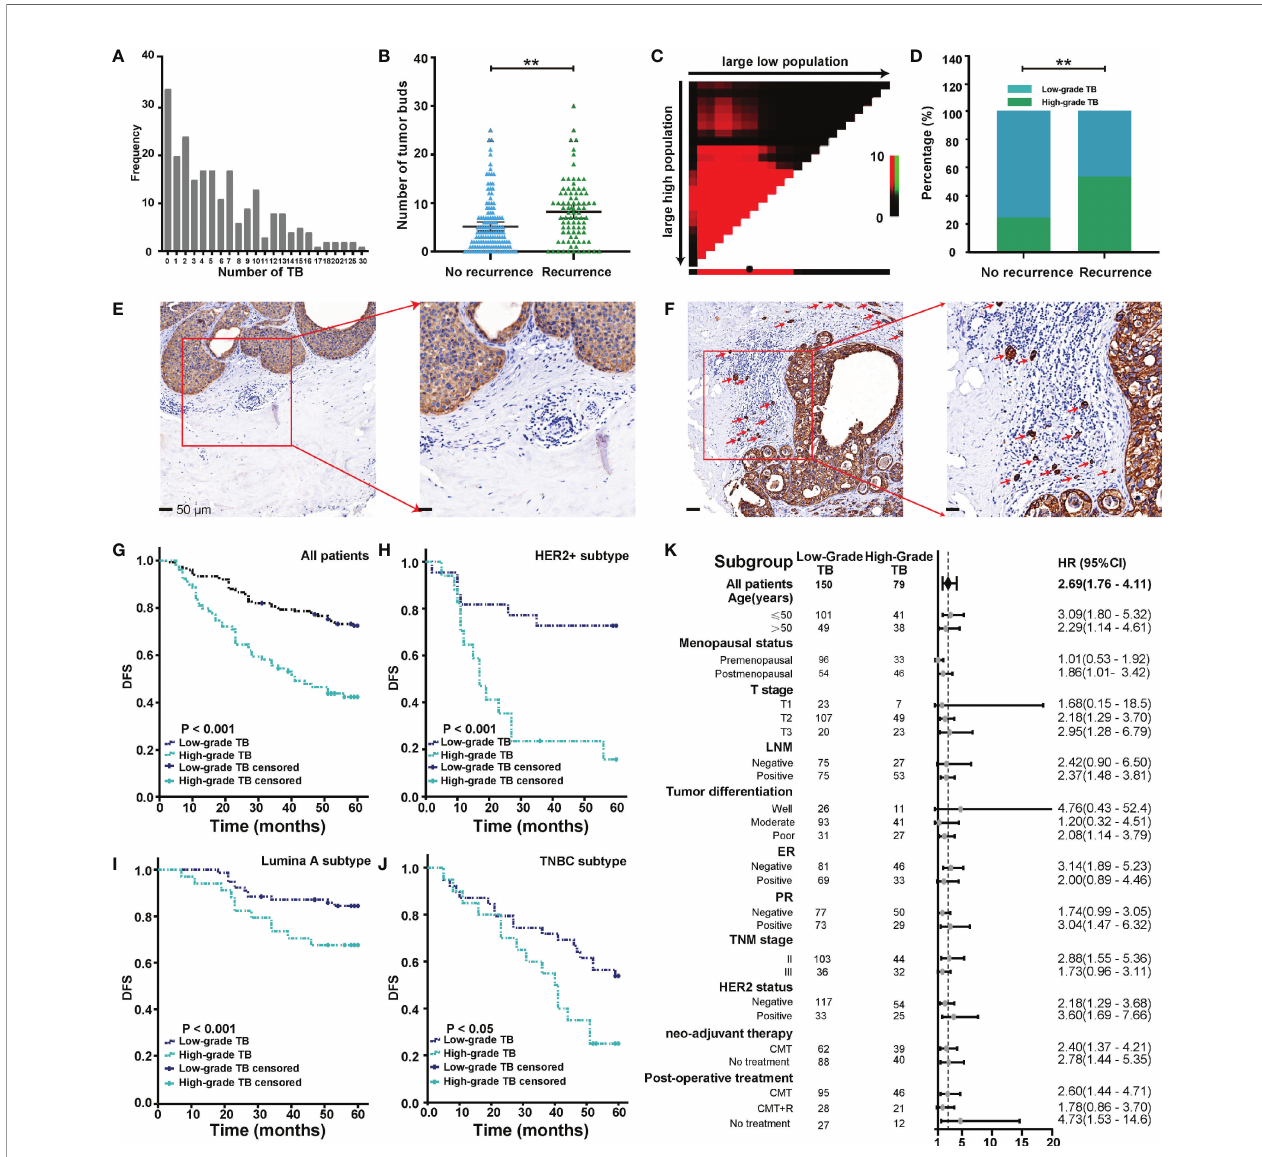
FIGURE 2 | Budding quanti fi cation and its relationship with clinical outcome. (A) Distribution of tumor buds in 229 cases of BC. (B) TB score in recurrent and nonrecurrent groups. (C) Analyses to de fi ne the optimal cutoff value for TB. (D) TB grade in recurrent and nonrecurrent groups. (E, F) Representative images of low- grade TB (E) and high-grade TB (F) . Red arrows point to tumor buds. (G) The Kaplan-Meier survival curve shows the DFS of BC after strati fi cation by TB grade. (H – J) The Kaplan-Meier survival curve shows DFS of different BC subtypes after strati fi cation by TB. (K) The forest map shows the prognostic signi fi cance of TB in different subgroups. ** p <